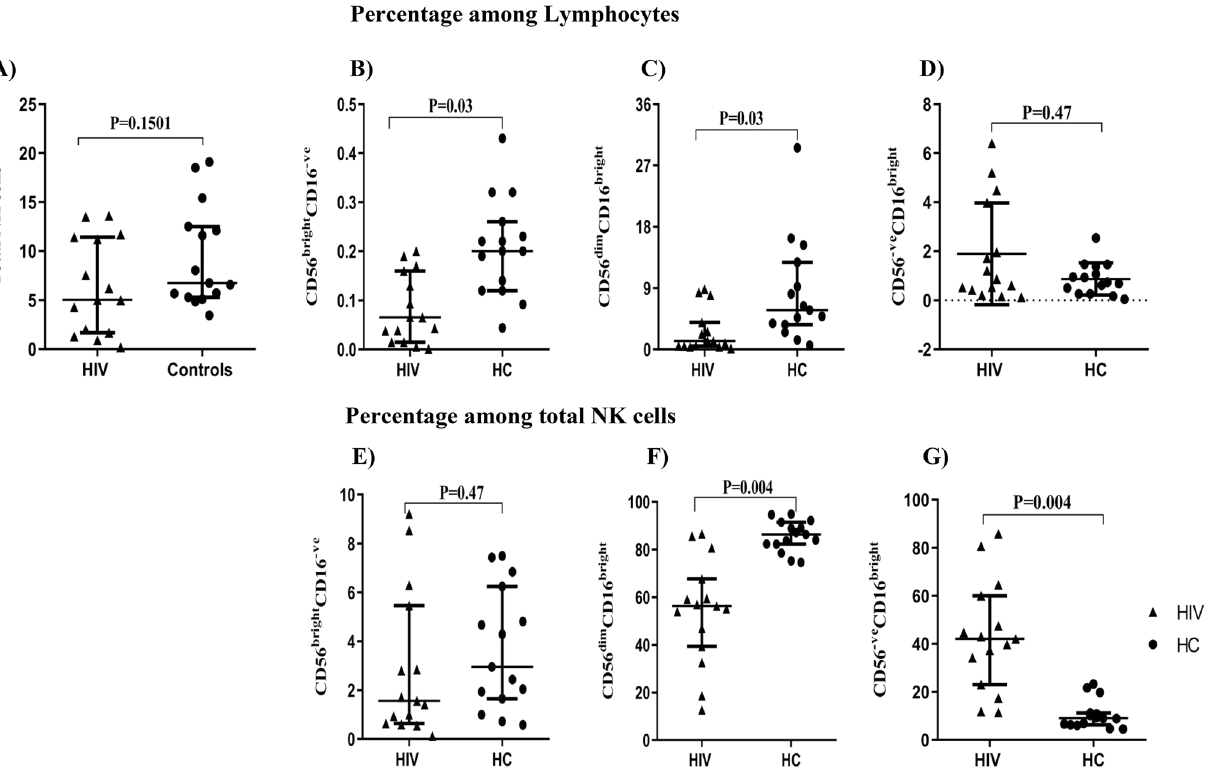
Figure 2. Total NK cells and subset distribution among the study groups. The frequency of total NK cells is indicated in the upper left corner, and was calculated based on the sum of CD56 bright CD16 − ve , CD56 dim CD16 bright , and CD56 − ve CD16 bright subsets ( A ). The percentage of NK subsets was gated among lymphocytes, the great grandparent node as defined in Fig. 1 ( B – D ), or total NK cells, the sum of all three NK subsets ( E – G ) from HIV (triangles, n = 15) or HC (circles, n = 15). Mann–Whitney tests were performed with a p-value < 0.05 considered statistically significant. The median and 25th and 75th percentile are indicated on each plot.